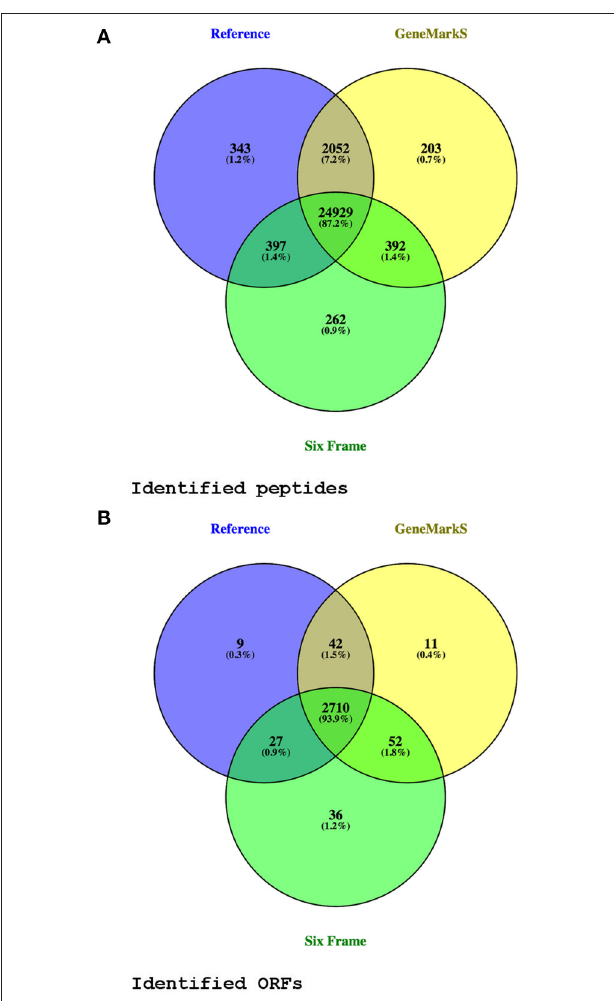
FIGURE 2 | Peptide and ORF identification venn diagrams. Panel (A) compares peptide identifications from three different database searches. Panel (B) shows the genomic open reading frames (ORFs) with at least one unique peptide identified, from the different databases searches. Only peptides identified in more than one replicate were considered. Two identified Reference proteins spanning multiple ORFs (A4ZHT6 and A4ZHR8), not mapping on a one to one basis to a genomic ORF, are included in the diagram as separate